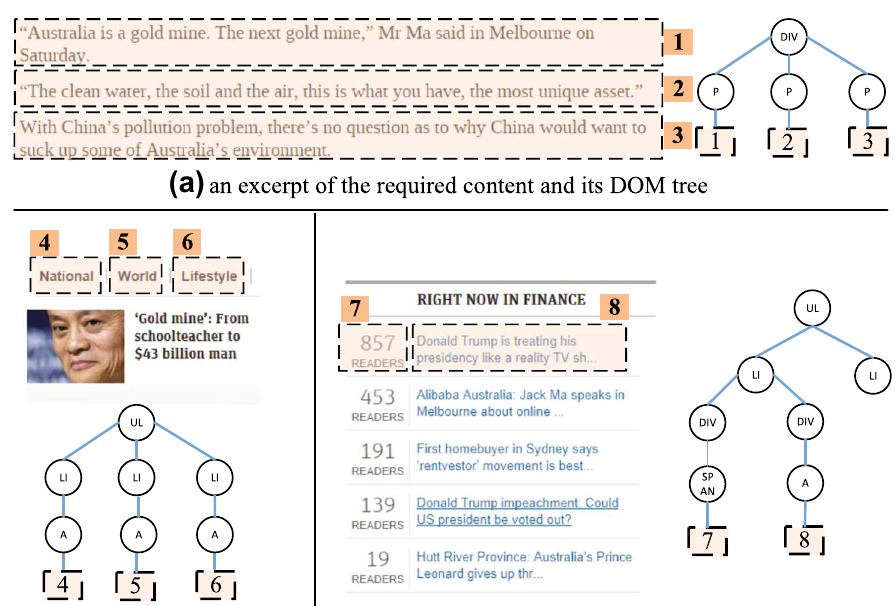
Fig. 3 Punctuation marks